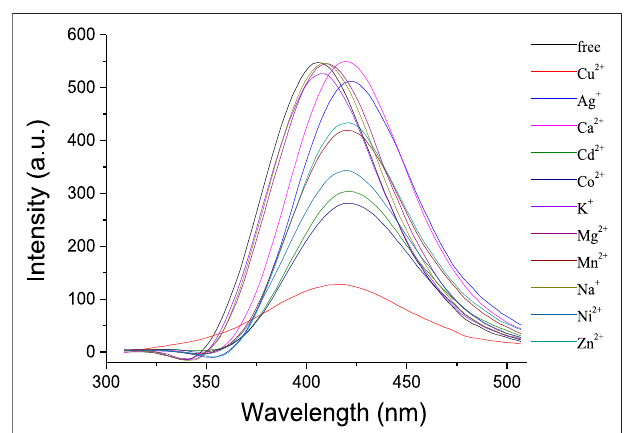
FIGURE 3 | Fluorescence spectra ( λ exc (cid:1) 334 nm, Slit (cid:1) 2.5) of 1 (1 × 10 − 6